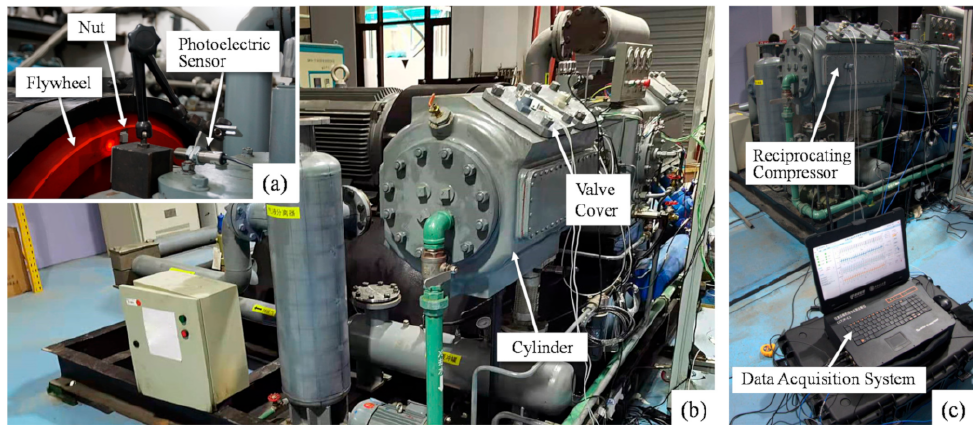
Figure 5. Experimental facilities: Arrangement of photoelectric sensor ( a ), the experimental compres- sor and its cylinders and valves ( b ), the data acquisition system ( c